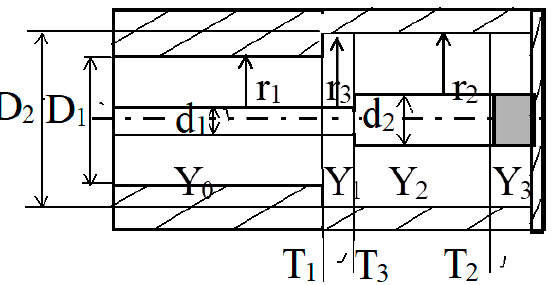
Figure 4. Design of a coaxial matched load with a compensating element.